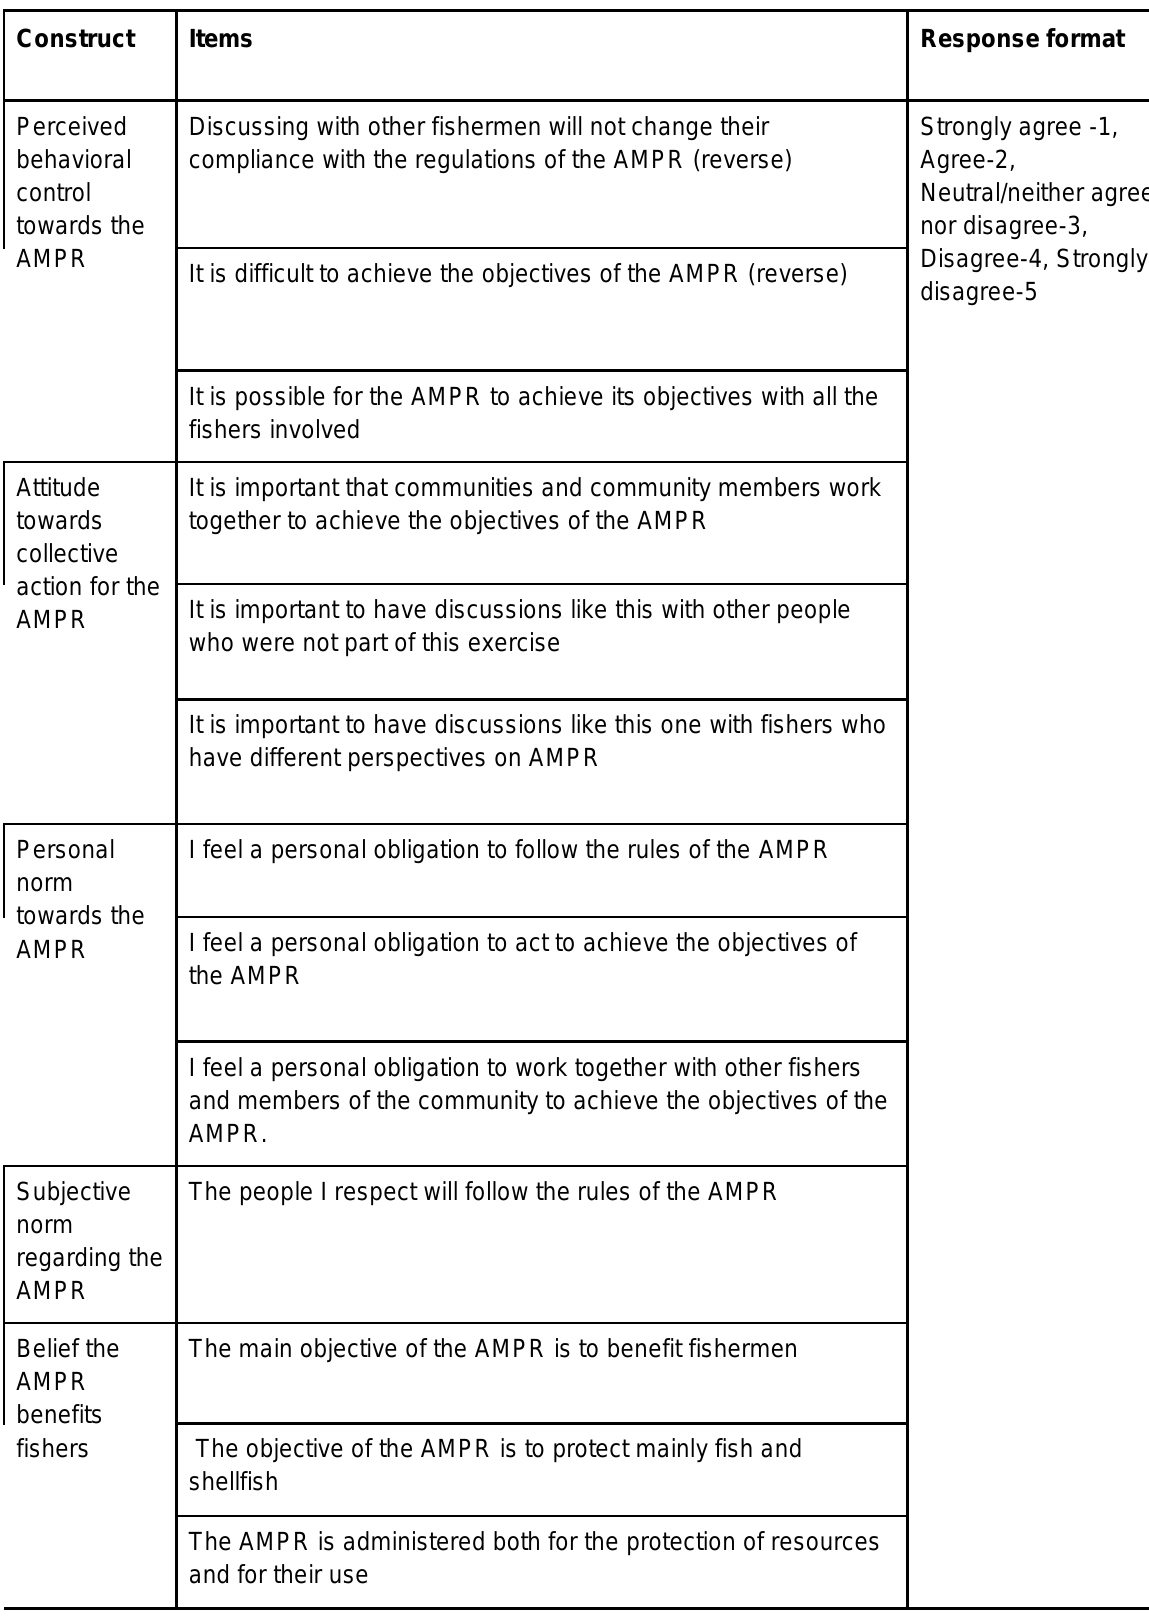
Table A2.1 Constructs, items and response format used to understand the behavioral intention to support the